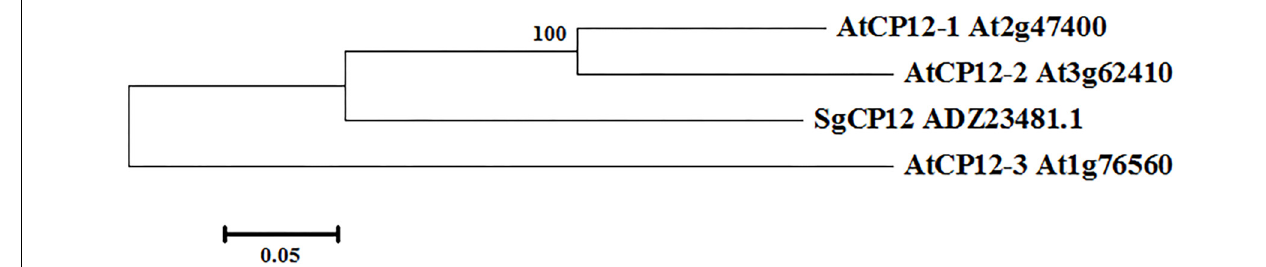
FIGURE 2 | Phylogenetic relationship between SgCP12 and AtCP12 members in Arabidopsis thaliana . The phylogenetic tree was constructed with the DNAMAN program. The bar represents the branch length equivalent to 0.05 amino acid changes per residue.